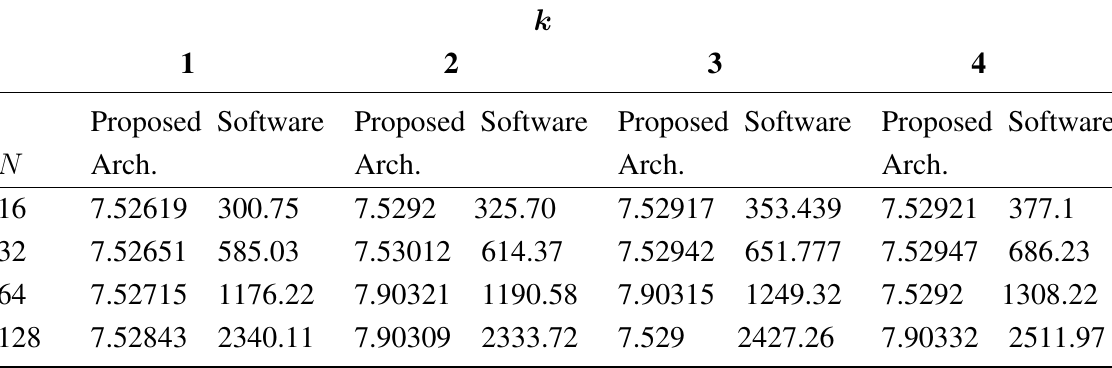
Table 6. The CPU time of the proposed hardware architecture and its software counterpart for different k and N values. (in ms